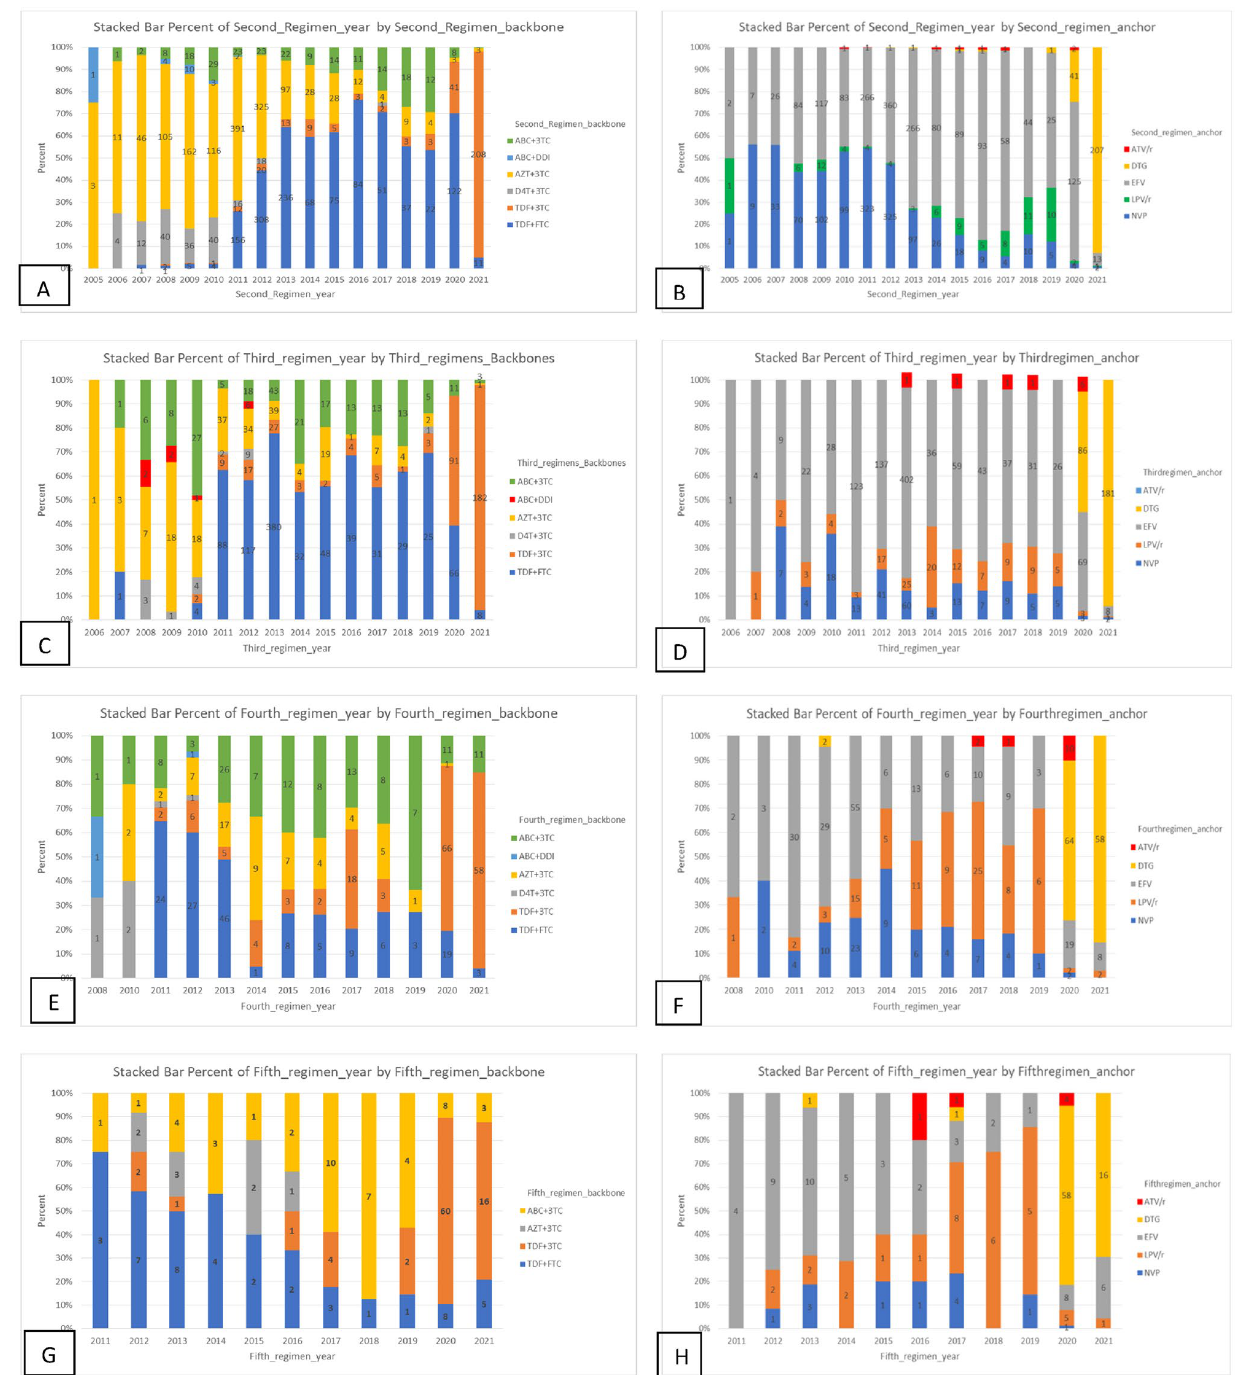
Figure 5. Distribution of cART regimens’ backbones and anchor drugs that were substituted and switched from 1st up to 5th regimen across study years among PLWHA in hospitals of Asmara, 2005–2021. Distribution of ( A , C , E , G ) backbone and ( B , D , F , H ) anchor drug classes prescribed in first cART regimens by year (2005 ‒ 2021). Anchor drugs: NNRTI Non-nucleoside reverse transcriptase inhibitor, PI Protease inhibitor (LPV/r: Lopinavir/ ritonavir and ATV/r: Atazanavir/ritonavir), INSTI intergrase strand transfer inhibitor (DTG: Dolutegravir). Backbone drugs: ABC Abacavir, TDF Tenofovir disoproxil fumarate; 3TC: lamivudine, FTC: